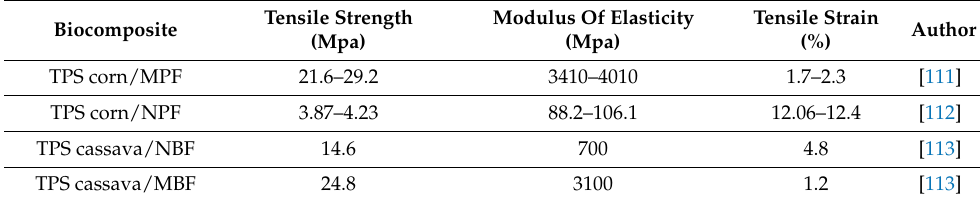
Table 8. Tensile properties of TPS-based